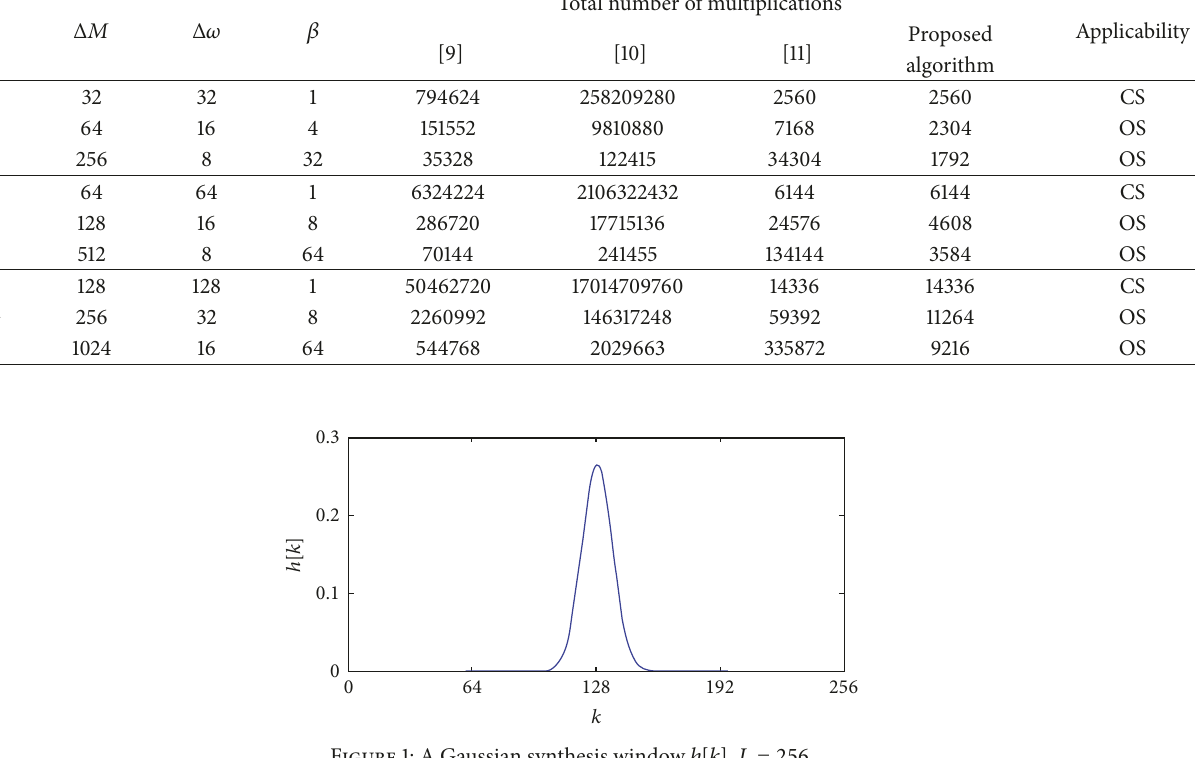
Figure 1: A Gaussian synthesis window ℎ[𝑘] , 𝐿 = 256 .